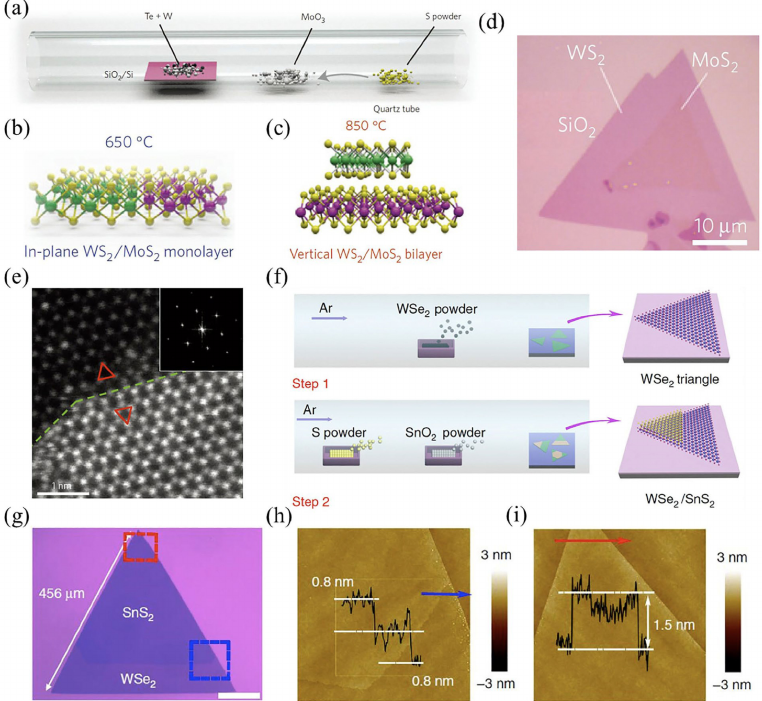
Figure 8. Depiction of synthesis mechanism of vdWHs: ( a ) demonstration of WS 2 /MoS 2 heterostruc- ture procedure. ( b , c ) In-plane and vertical stacking of WS 2 (650 ◦ C) and MoS 2 (850 ◦ C) monolayers to grow (in-plane/vertical) heterostructures. ( d ) Display of optical photograph for an in-plane WS 2 /MoS 2 heterostructure on an SiO 2 substrate. ( e ) Z-contrast image of the step edge of WS 2 /MoS 2 bilayer on SiO 2 substrate. The green dashed boundary implies the edge of the step, while the two triangles show the orientation of the MoS 2 (top) and WS 2 (bottom) layers. Adapted with permission from Ref. [132]. Copyright 2014, Nature Publishing Group. ( f ) Pictorial demonstration of dual-step vapor epitaxy fabrication of WSe 2 /SnS 2 vdWHs. ( g ) Optical photograph of a stacked triangular flake of 1L SnS 2 /1L WSe 2 . ( h ) AFM photograph of the section in ( g ) indicated by the blue rectangle. ( i ) AFM photograph of the section in ( g ) indicated by the red rectangle. Adapted with permission from Ref. [119]. Copyright 2017, Nature Publishing